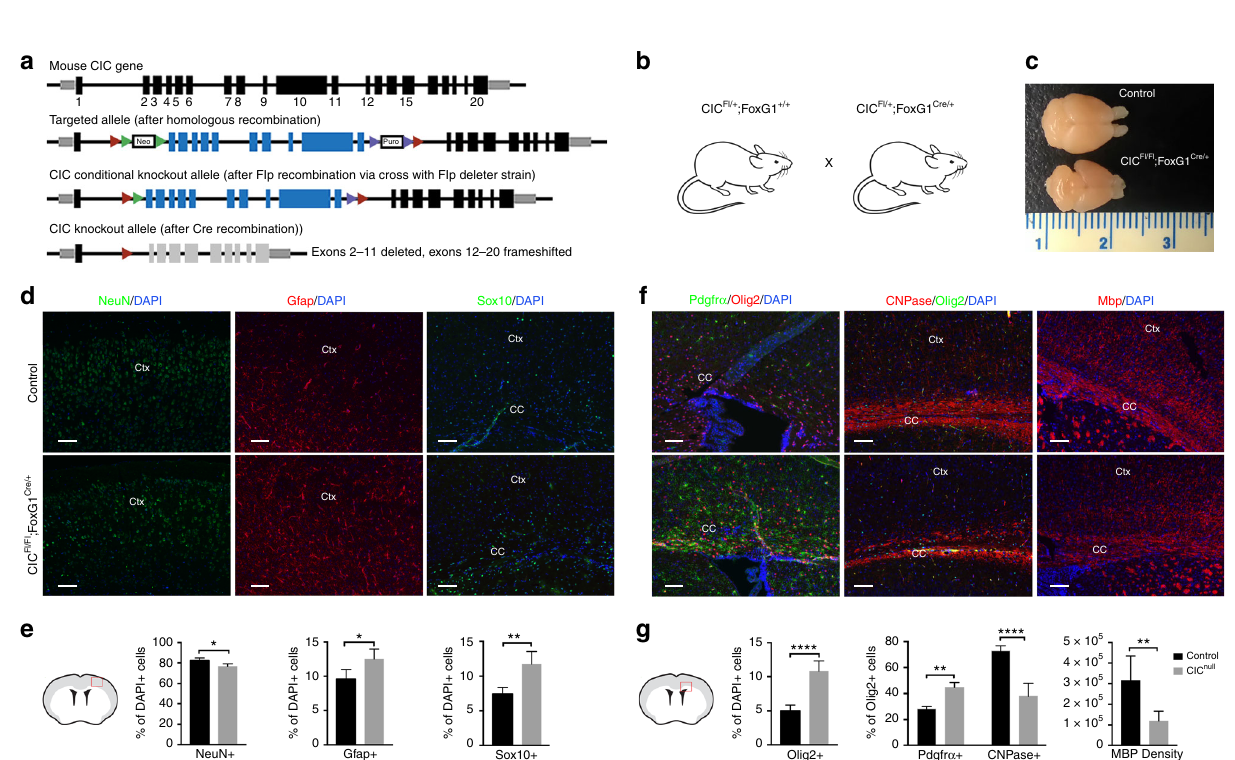
Fig. 1 Differential Cic expression among cell types in the developing and mature brain. a – h Representative images of immuno fl uorescence staining for Cic expression in a Sox2 + stem cell populations in E12 subventricular zone, b P21 subventricular zone, and c P56 hippocampal dentate gyrus subgranular zone. Cic expression in glial cells in the adult brain showing localization in d Gfap + cortical astrocytes, e Pdgfra + white matter OPCs, and f CNPase + mature oligodendrocytes. Cic expression in neuronal populations in g E15 Tbr2 + early-born neurons in the SVZ and IZ, h E15 Tbr1 + late-born neurons in the cortical plate, and i adult post-mitotic NeuN + cortical neurons. j Quantitation of Cic nuclear staining intensities, plotted by brain cell types. All quantitation performed on P56 brain except Tbr2 and Tbr1, which were analyzed at E15. Each point represents one cell quantitated. Results from a minimum of 24 cells per marker from the boxed regions used for image analysis; data are from n = 5 brains. Pairwise comparisons between cell types performed by ANOVA with Tukey ’ s post hoc test. Source data are provided as a Source Data fi le. Scale bar: 50 μ m. Data shown as mean ± SD. * p < 0.05, ** p < 0.01, **** p < 0.0001. Labels: LV – lateral ventricle, GCL – granule cell layer, SGZ – subgranular zone, SVZ – subventricular zone, Ctx – cortex